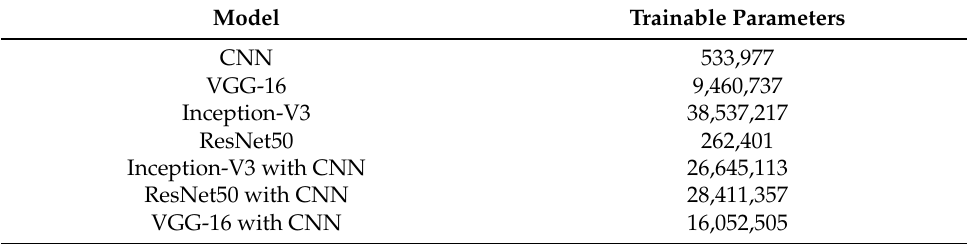
Table 3. Trainable parameters for different deep learning